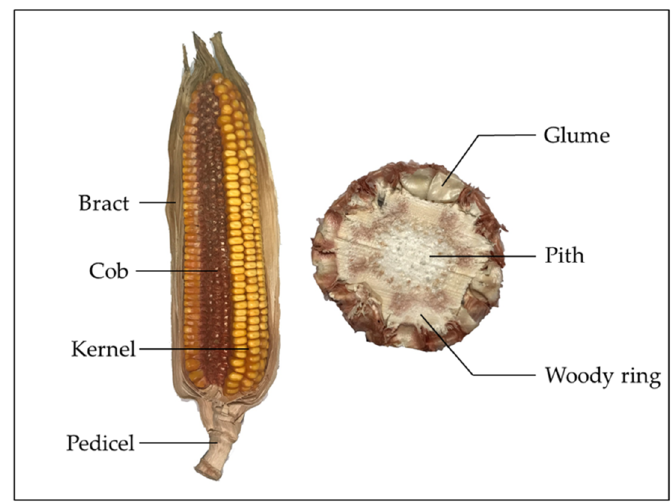
Figure 1. Layered structure of corn cob. Table 1. Physical parameters of different components of corn cob (100